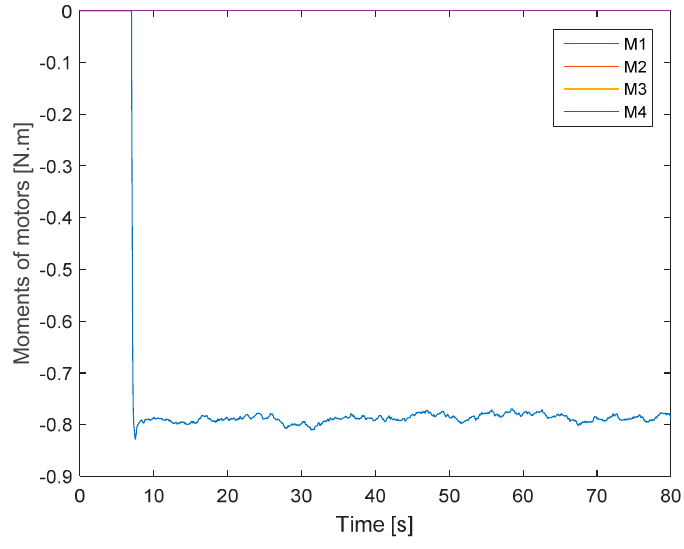
Figure 4. Motor offsets caused by the fault.